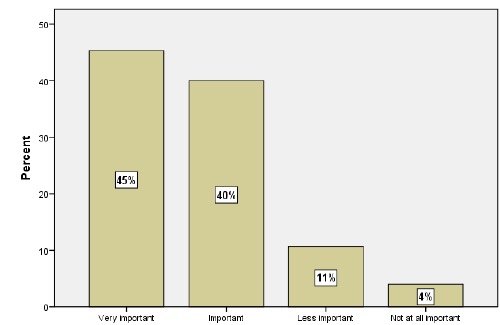
Figure 6: Bar chart showing percentage of respondents’ opinion about how they consider sharing of academic resources by using the social media.